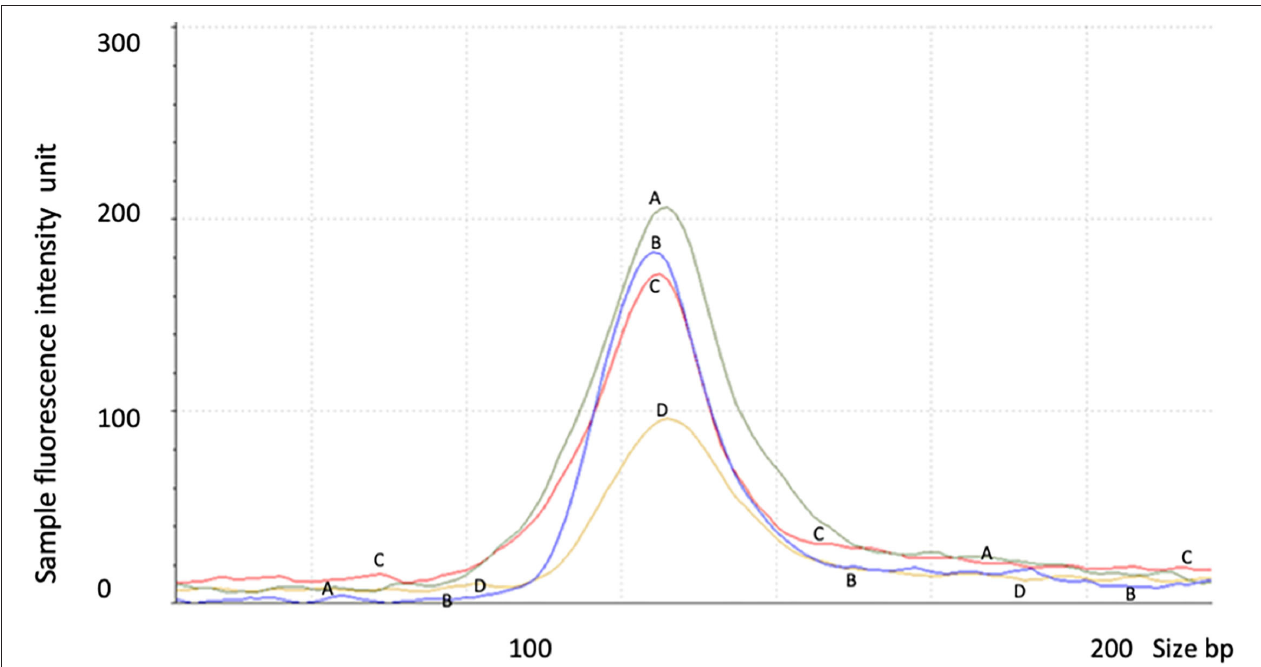
FIGURE 3 | RNA decay observed in proband 1 with STXBP1 deletion not observed in proband 2 with nonsense mutation. Control 1 (A) = 6 year old male, control 2 (C) = 1 year old male, proband 1 (D) = 2 year old male with partial deletion of STXBP1 , and proband 2 (B) = a 6 year old male with c.1663G > T nonsense mutation of STXBP1 . The data were averaged from triplicates for each sample. The test was repeated for at least three times.